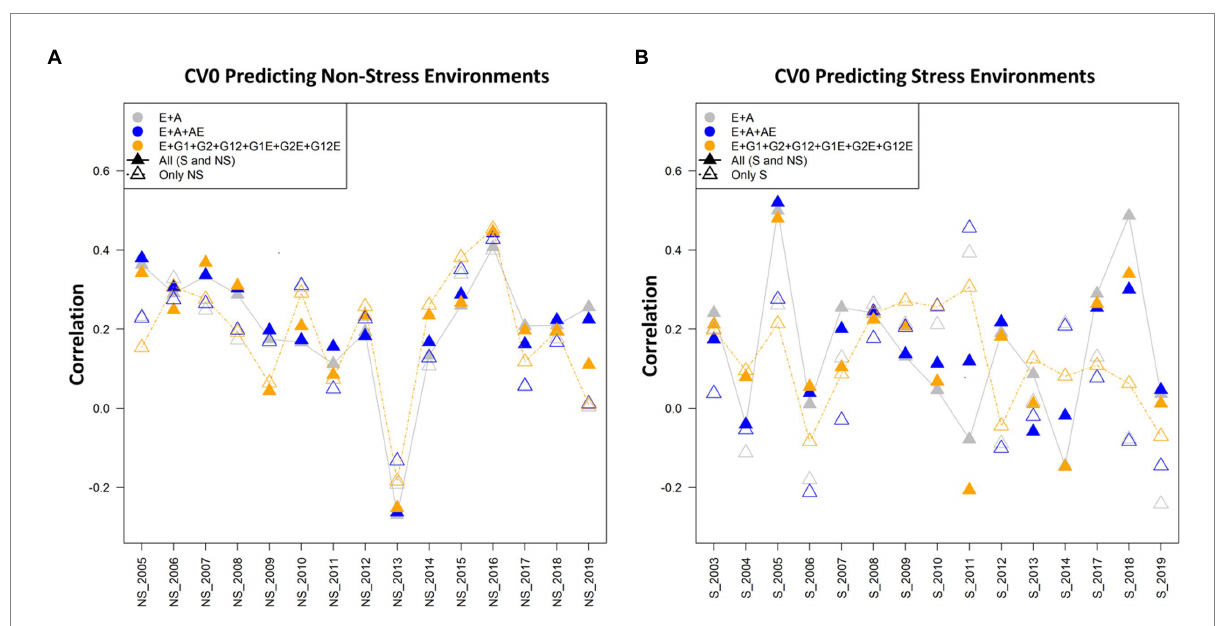
FIGURE 4 (A) The average correlation values obtained from predicting the grain yield for new environment/year (CV0) under the non-stress conditions using non-stress (NS) and combined [All (S and NS)] datasets. The plot depicts the correlations between the predicted and estimated values across the years 2005–2019, using model 1 (E + A), 2 and 5, respectively. (B) The average correlation values obtained from predicting the grain yield for new environment/year (CV0) under the stress conditions using the stress (S) and combined [All (S and NS)] datasets. The plot depicts the correlations between the predicted and estimated values across the years 2003–2019, using model 1 (E + A), 2 and 5, respectively.